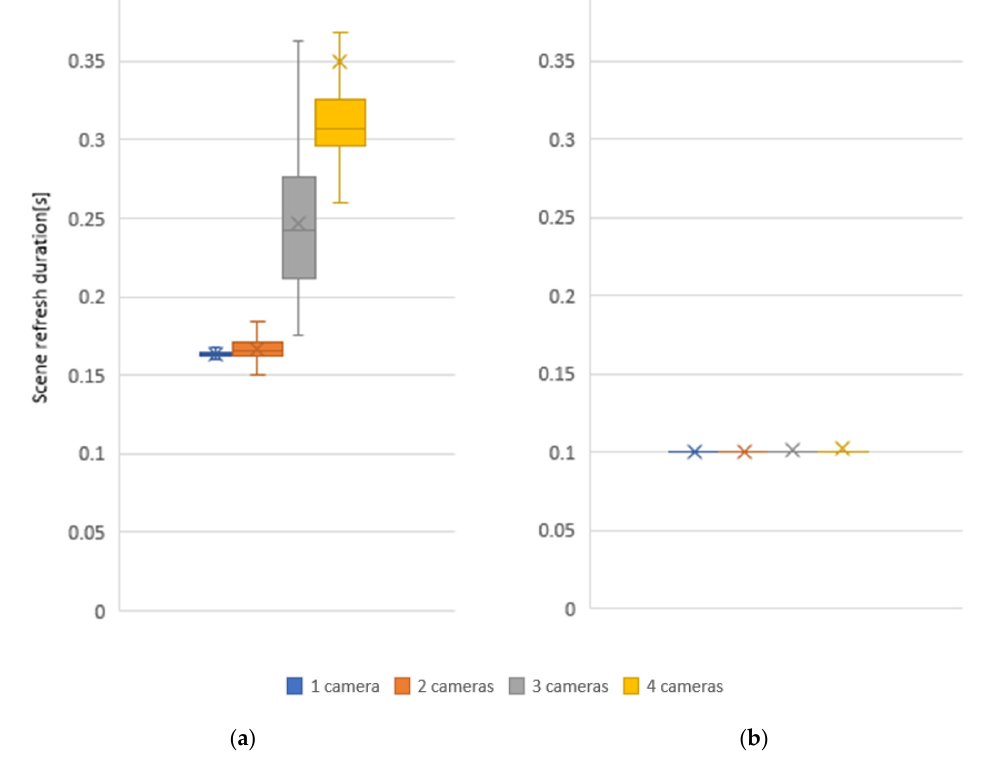
Figure 12. Effect of the number of cameras on the scene refresh duration for 1280 × 720 camera resolution and voxel size 20 mm: ( a ) centralized; ( b ) distributed. Scene refresh rate measurements based on the number of cameras have clearly shown that a system that filters data from each camera separately and sends the resulting data to the main device where all data are combined into a global voxel map is more efficient to use. The distributed system refresh rate is faster by 38.7% when using one camera, by 40.1% when using two cameras, 59.4% when using three cameras, and 71.5% when using four cameras. This ensures a more stable refresh rate of the whole scene even with larger numbers of sensors and reduces the network requirements as it does not need to send source data from cameras between devices. Data sent over the network within a centralized system is sent in raw format (depth image), which equals the image width times height times the bit rate of the depth stream for each camera in the system. For example, when capturing at 640 × 480 resolution and a 32-bit depth image, then 9.8 Mbit of data needs to be transferred. For three cameras, this is therefore 29.4 Mbit/scene refresh. While in a distributed system, the data sent is based on the current scenario (nothing is sent if there are no undefined objects). When sending voxels (either an index in the grid or specific X,Y,Z coordinates), one can count 3 × 32 bits per voxel, whereas, in a normal scenario, the unit sends less than 100 voxels on average. Then, on average, 9.3 Kbit per camera can be counted, and with three cameras, it is only 27.9 Kbit. To make a distributed system less efficient, the number of voxels sent would have to be higher than 1/3 of the number of pixels which is very unlikely with the current filtering. Needed time may also be compared for implementing the system. In the case of a centralized system (MoveIt!), it was needed to manually change parts of the code respon- sible for placing cameras into the workspace (if no additional script was created for con- ducting this routine instead of us). That means if there was a need to change the number